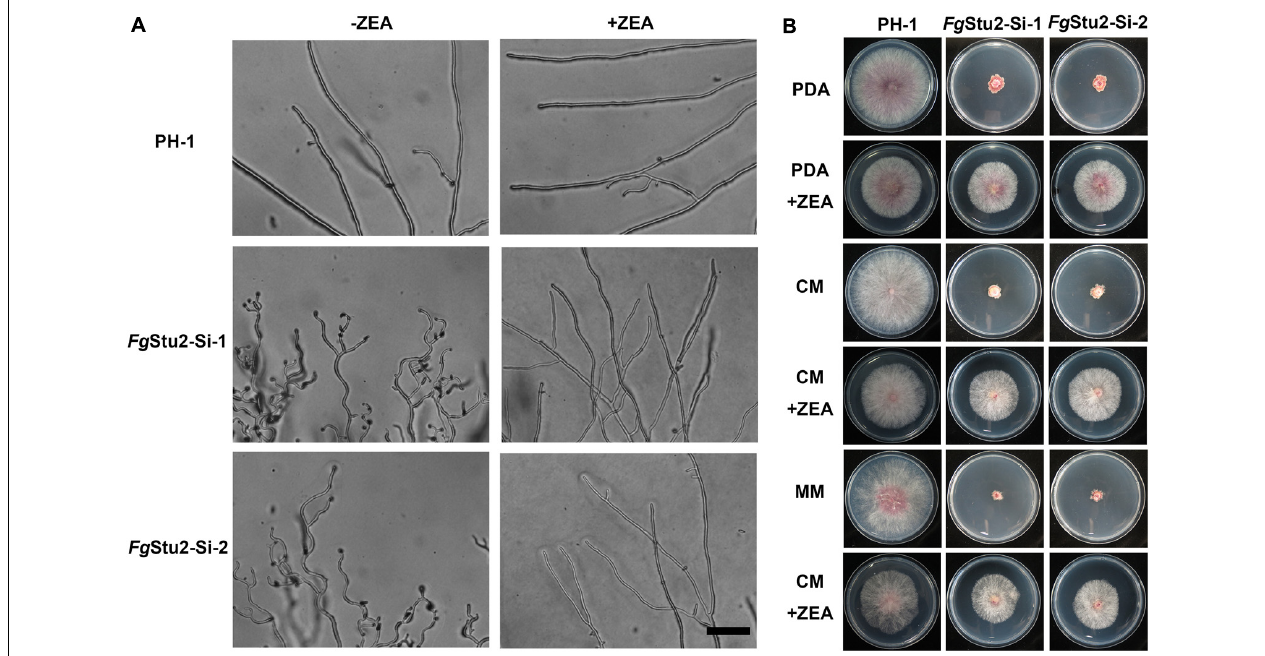
FIGURE 5 | Roles of Fg Stu2 gene in hyphal and colonial morphology. (A) Hyphal morphology was photographed after strains were incubated on potato dextrose agar (PDA) plants with or without 30 µ M zearalenone (ZEA) for 24 h at 25 ◦ C. Bar = 50 µ m. (B) Colony morphology was photographed after strains were inoculated on potato dextrose agar (PDA), complete medium (CM), and minimal medium (MM) plants with or without 30 µ M ZEA for 3 days at 25 ◦ C.